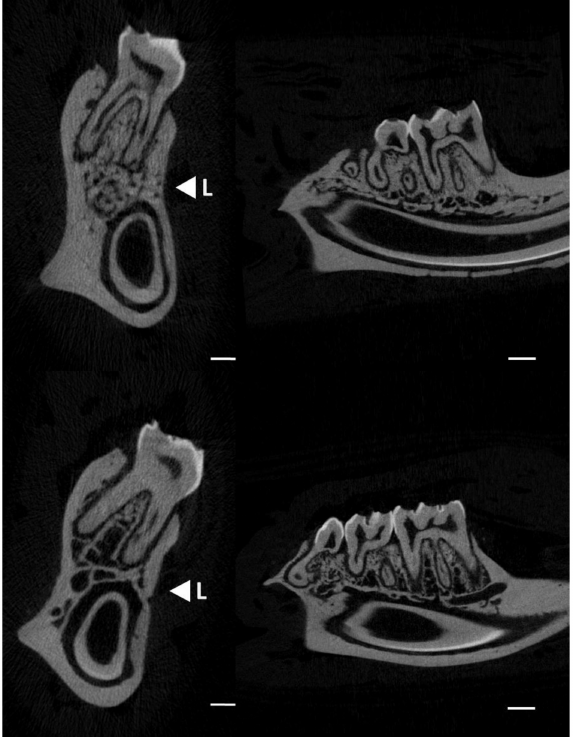
Figure 2. Micro-CT images showing the changes in alveolar bone in rat mandibles (transversal and sagittal sections) in the control (upper images) and lead exposure (lower images) groups. <L; direction for the mechanical load (three-point bending test). Scale bars: 1